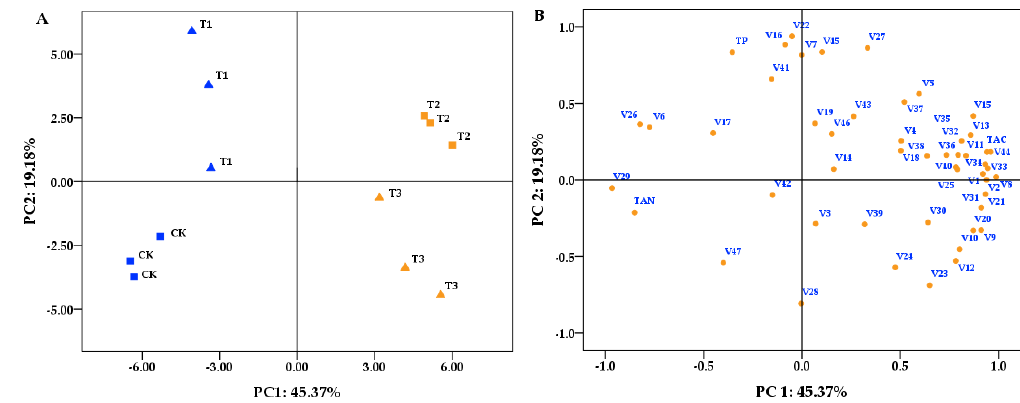
Figure 2. Principal Component 1 (PC1) versus PC2 scatter of the Cabernet Sauvignon wines. ( A ) Score plot. ( B ) Loading plot of Components 1 and 2. The number of volatile compounds (b) corresponds to the volatile compound number in Table 3.